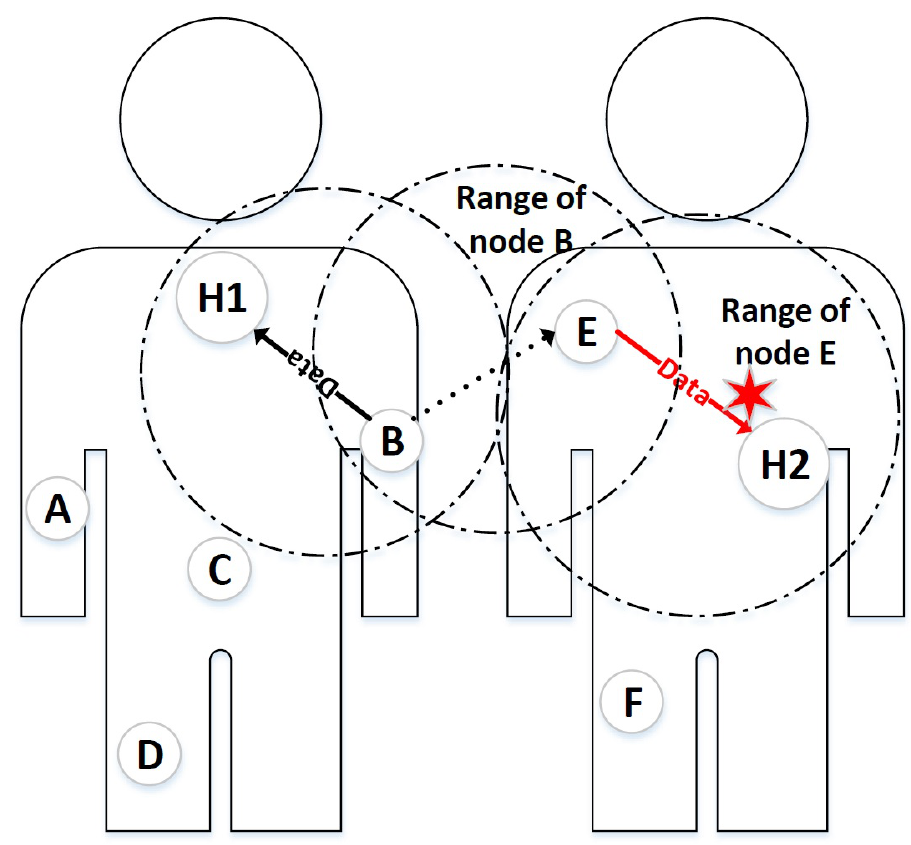
Figure 2. Exposed node problem in multiple IEEE 802.15.6 CSMA/CA based networks.